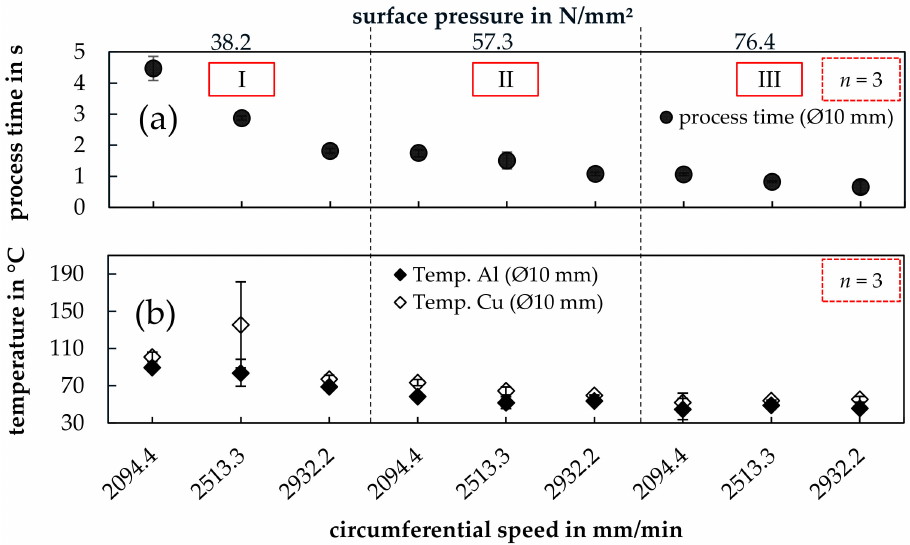
Figure 5. Influence of the welding process parameters on the process time ( a ) and heat propagation ( b